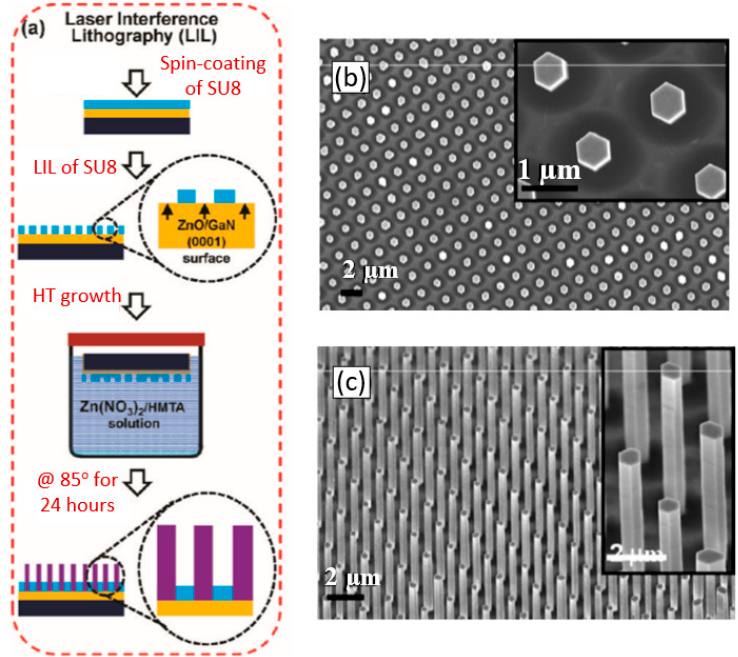
Figure 25. ( a ) Schematics of the fabrication sequences of vertically aligned ZnO NW arrays using laser interference lithography (LIL); ( b ) optical image of a 2 in. Si wafer with a SU-8 open-hole pattern